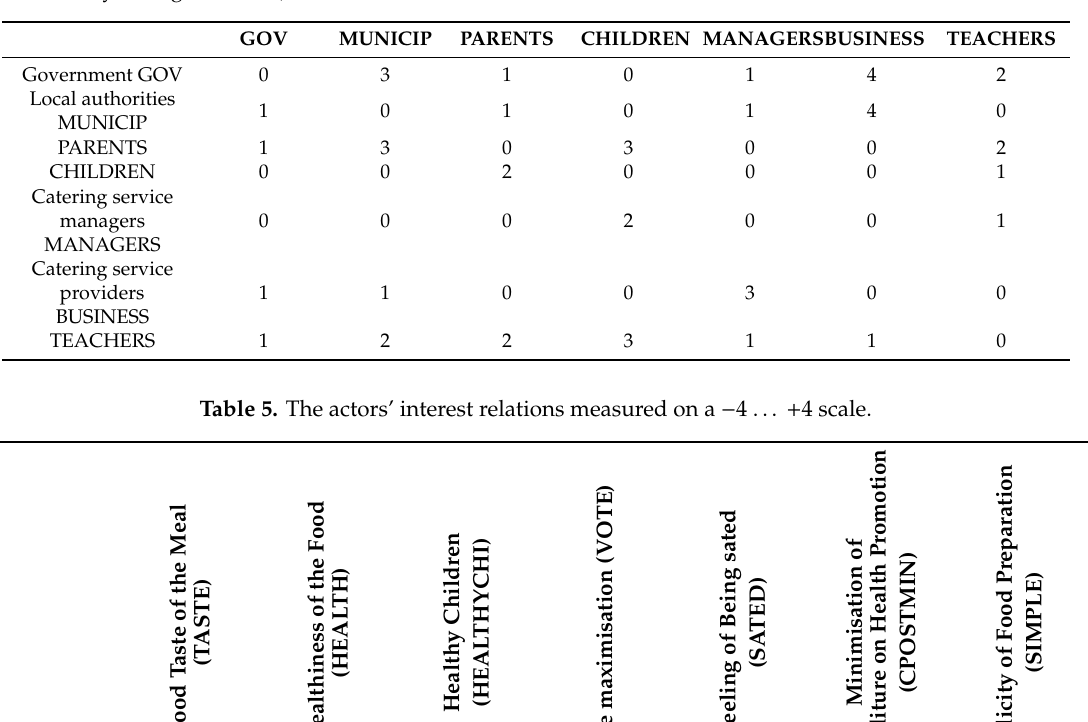
Table 4. The matrix of direct influences on actors measured on a 0–4 scale (0—no direct influence, 4—very strong influence).